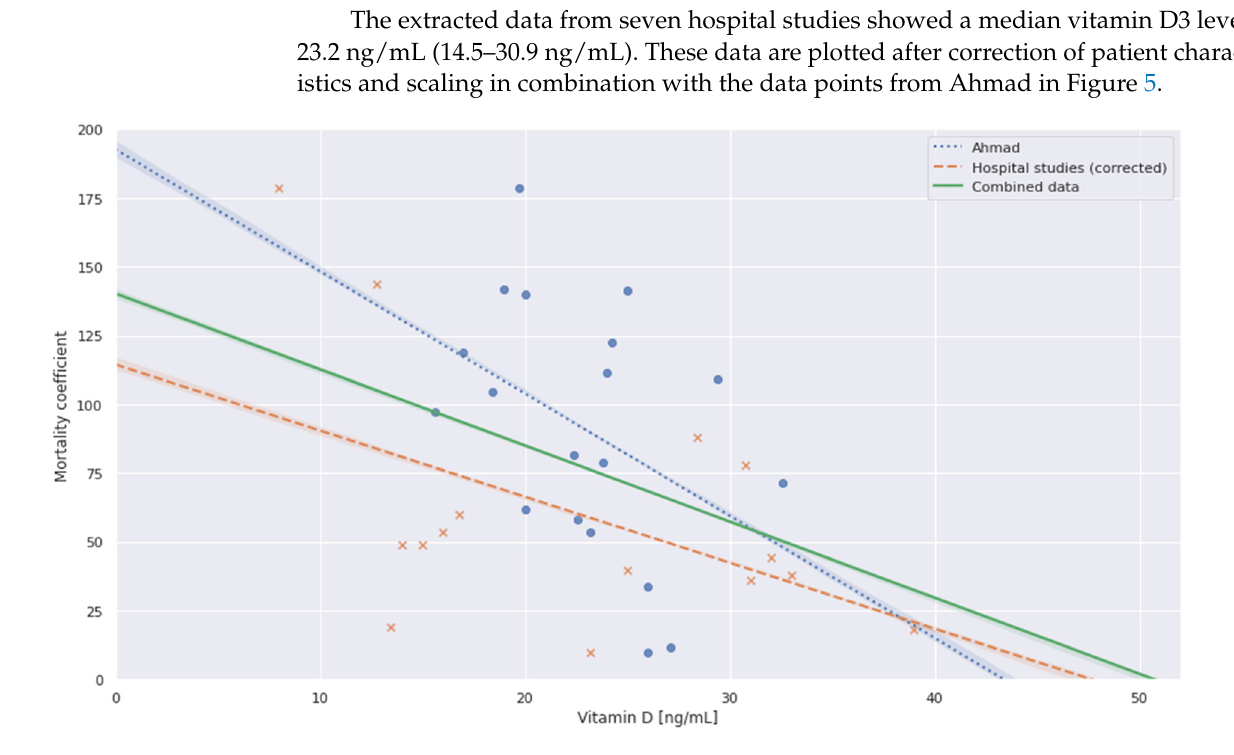
Table 4. Correlation of mortality and vitamin D blood levels for the respective datasets.